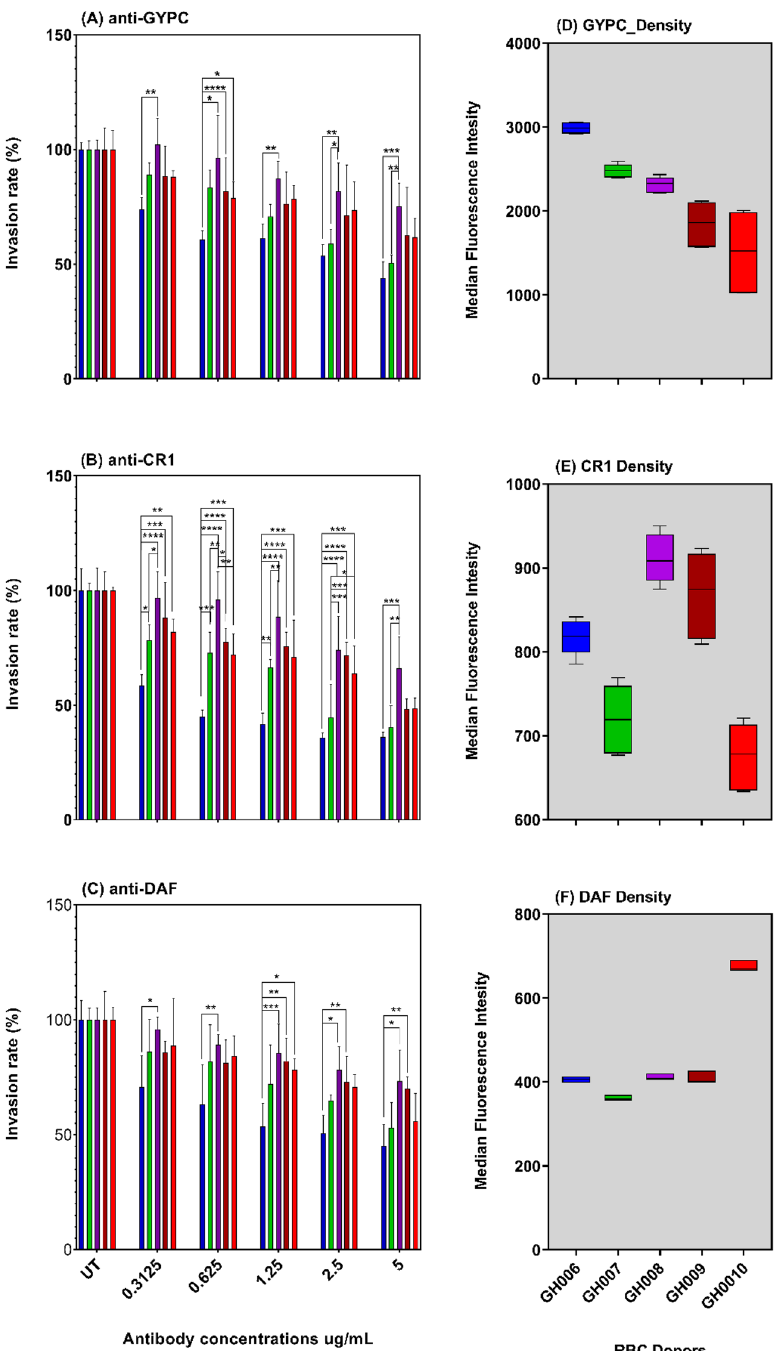
Figure 6. Antibody-dependent invasion inhibition assays in donor erythrocytes with different levels of surface antigens. Schizont-infected erythrocytes were co-incubated with antibody-sensitized uninfected erythrocytes from donors expressing different levels of erythrocyte receptors. The parasites’ DNA was labelled with Hoechst 33,342, 18–24 h’ post-incubation and the resulting parasitemia was quantified by flow cytometry. For each donor, the parasitemia in the corresponding mock-treated erythrocytes (similarly processed erythrocytes co-incubated with equivalent volume of RPMI 1640 with the IgY) was used to ascertain the antibody-dependent invasion inhibitory, following normalization using a single erythrocyte donor (also used for the parasites in vitro culturing). ( A )–( C ) represent the antibody-dependent invasion inhibition of pooled data from two different P. falciparum strains (3D7 and MISA011). ( D )–( F ) represent the differential expression of erythrocyte receptors assessed in ( A )–( C